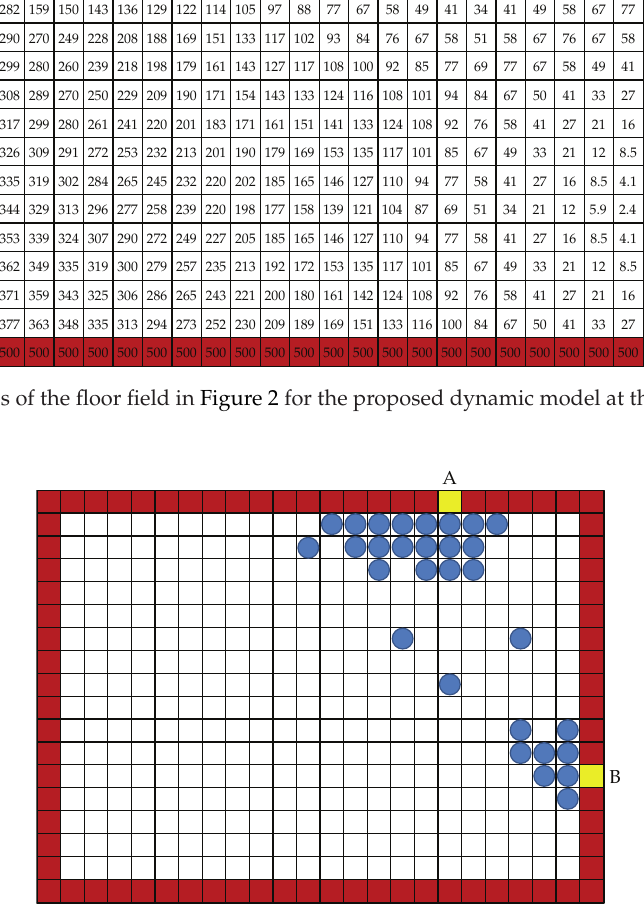
Figure 4: Snapshot of a simulation performed using the proposed model of the floor field in Figure 1 after 70 time steps, showing 11 pedestrians moving toward exit